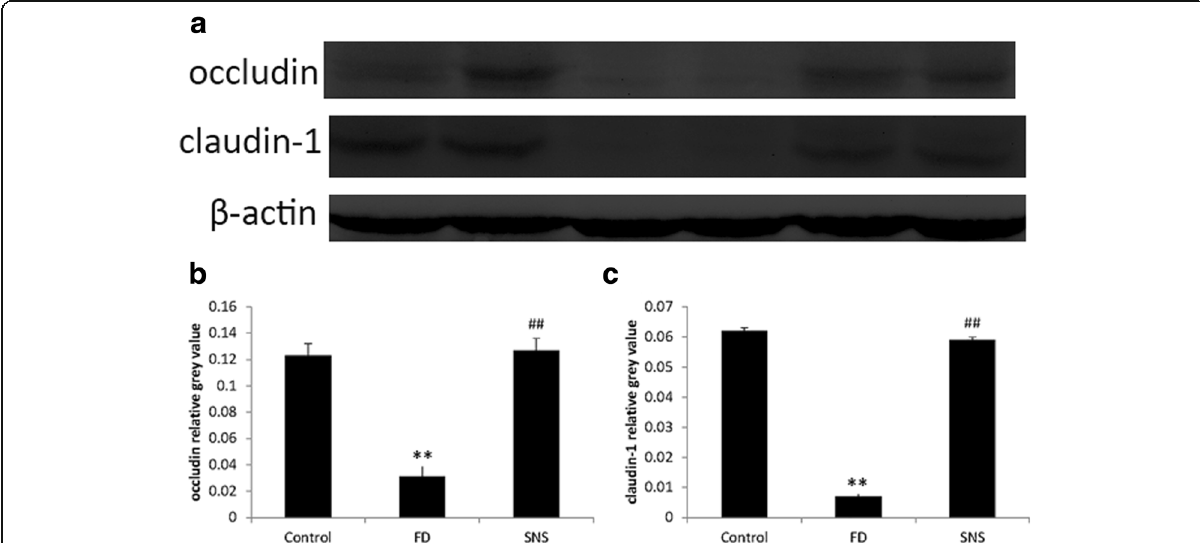
Fig. 3 Representative Western blot bands of TJ proteins ( a ).The expression level was normalized to the housekeeping protein β -actin ( b , c ). Compared with the control group, the expression of occludin and claudin-1 was significant lower in the model group and SNS treatment could restore these two TJ proteins. All data were represented as mean ± SEM (6 rats in each group). ** P < 0.01 compared with the control group; ## P < 0.01 compared with the model